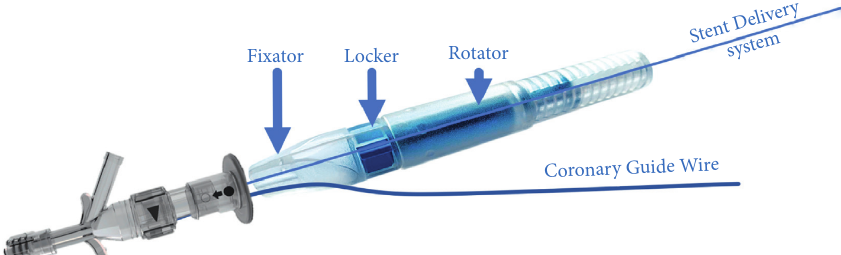
Figure 2: SPAS usability. SPAS support all coronary stent delivery systems. By introducing the stent from the back of the SPAS through the central main tunnel before the rapid exchange system is advanced over the coronary wire and the stent is introduced to the lesion in the coronary artery. While fixating the SPAS and the guide wire (with the thumb and index finger on the “fixator”, the “locker” is rotated until a click is felt), in order to tightly secure the SPAS on to the stent delivery system. Rather than pushing and pulling the stent inside the artery, the stent can be moved forward and backward to the accurate location by rotation of the “rotator”; clockwise drives the stent forward, and counterclockwise retracts the stent. At any point in which the operator does not feel comfortable or needs to proceed in the classic way, the “locker” is released and manual positioning can take place within